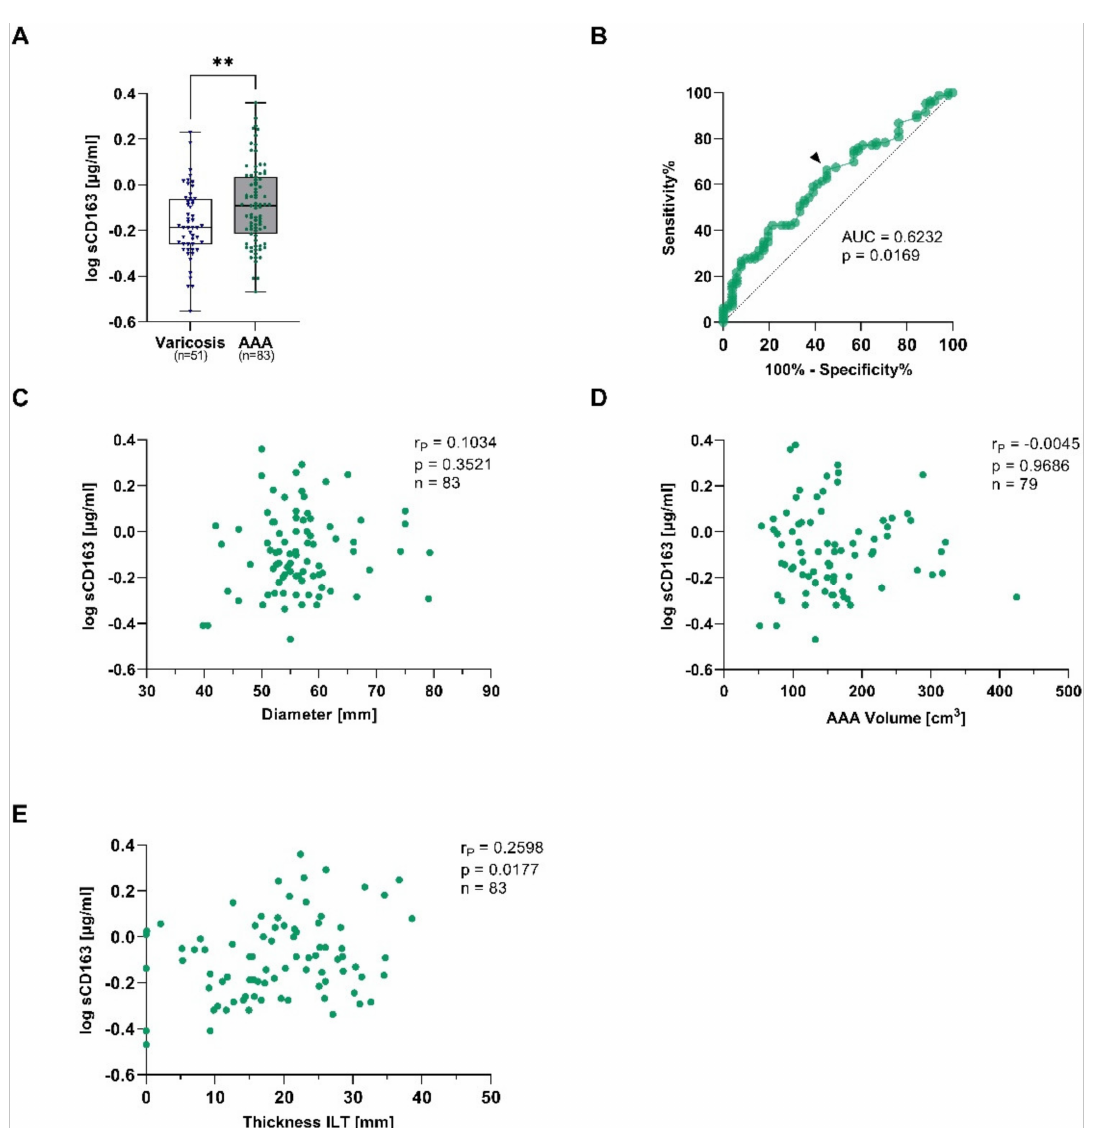
Figure 2. Plasma soluble CD163 concentrations and connections to AAA diameter, AAA volume, and thickness of the intraluminal thrombus (ILT) in AAA and corresponding controls. Plasma sCD163 was measured using ELISA, and and data were log transformed. ( A ), sCD163 concentrations were quantified in electively treated AAA patients (eAAA, green), and varicose controls (blue). ( B ), Receiver-operating characteristics (ROC) were used to determine the area under the curve (AUC) for obtaining the optimal cut-off value to discriminate AAA from controls with a high sensitivity. The black arrow indicates where the cut-off value was set. sCD163 concentrations were analyzed for correlations with ( C ), AAA diameter, ( D ), AAA volume and ( E ), thickness of the intraluminal thrombus (ILT). Data on sCD163 was not measurable in 2 varicose vein and 2 eAAA patients. In addition, no information on AAA volume was available for 4 eAAA patients. Statistics: Significant outliers were identified by Grubb’s outlier test and excluded from further analysis. The data are shown as ( A ), boxplots with individual values and were analyzed by unpaired t -test. ** p ≤ 0.01. ( C – E ), Pearson’s correlation coefficient (r P